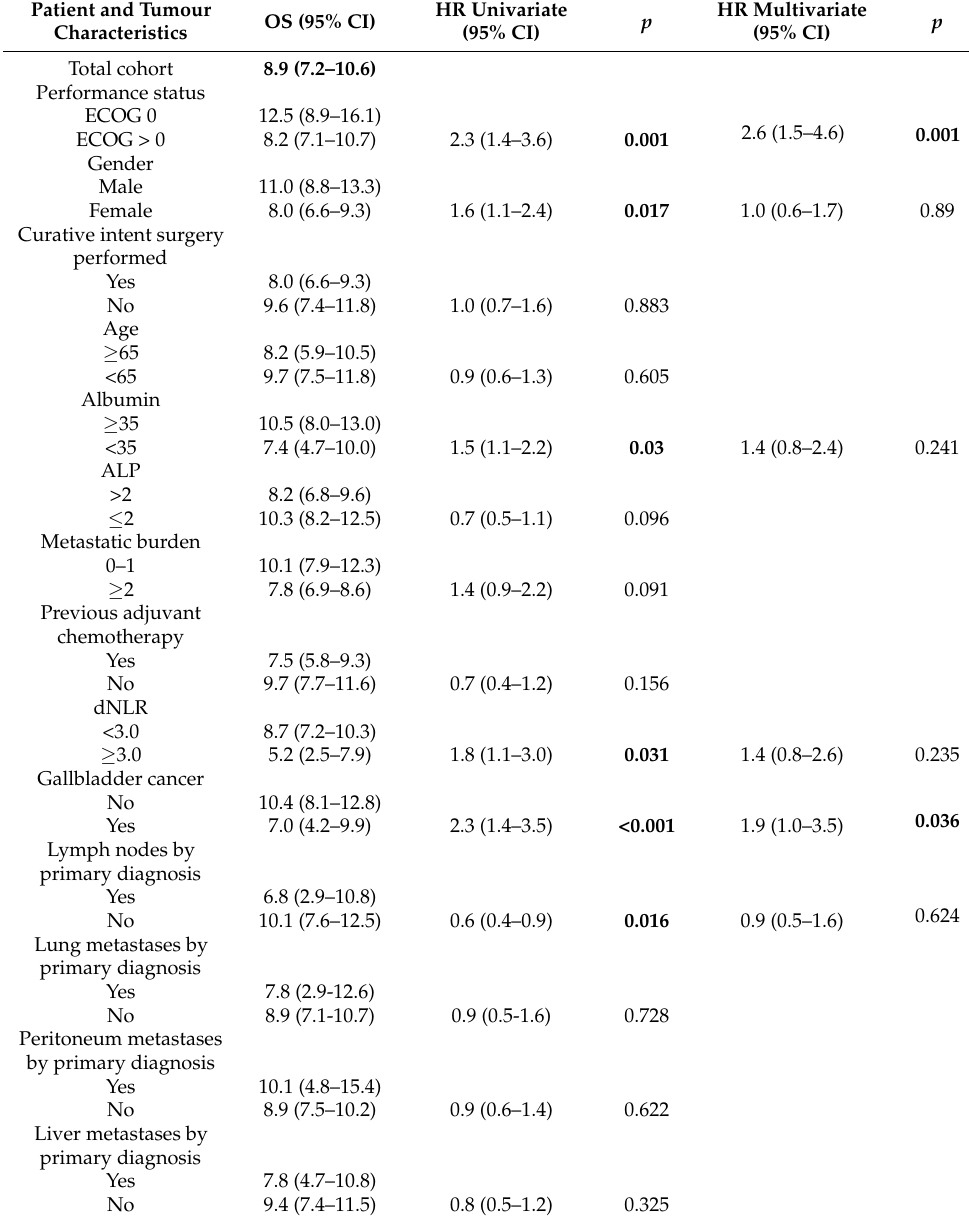
Table 3. Table showing median overall survival for different factors with univariate and multivariate